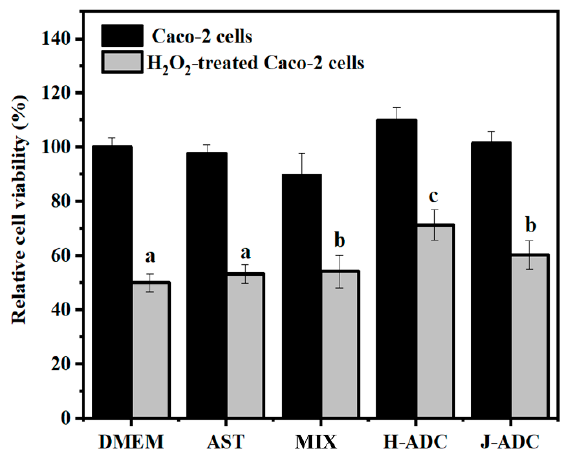
Figure 3. The cell viability of Caco-2 cells and H 2 O 2 -treated Caco-2 cells pretreated with different antioxidants ( n = 6). a–c Different letters show statistically significant differences ( p < 0.05) between different groups, whereas bars labelled with the same letter correspond to results that show no statistically significant differences.